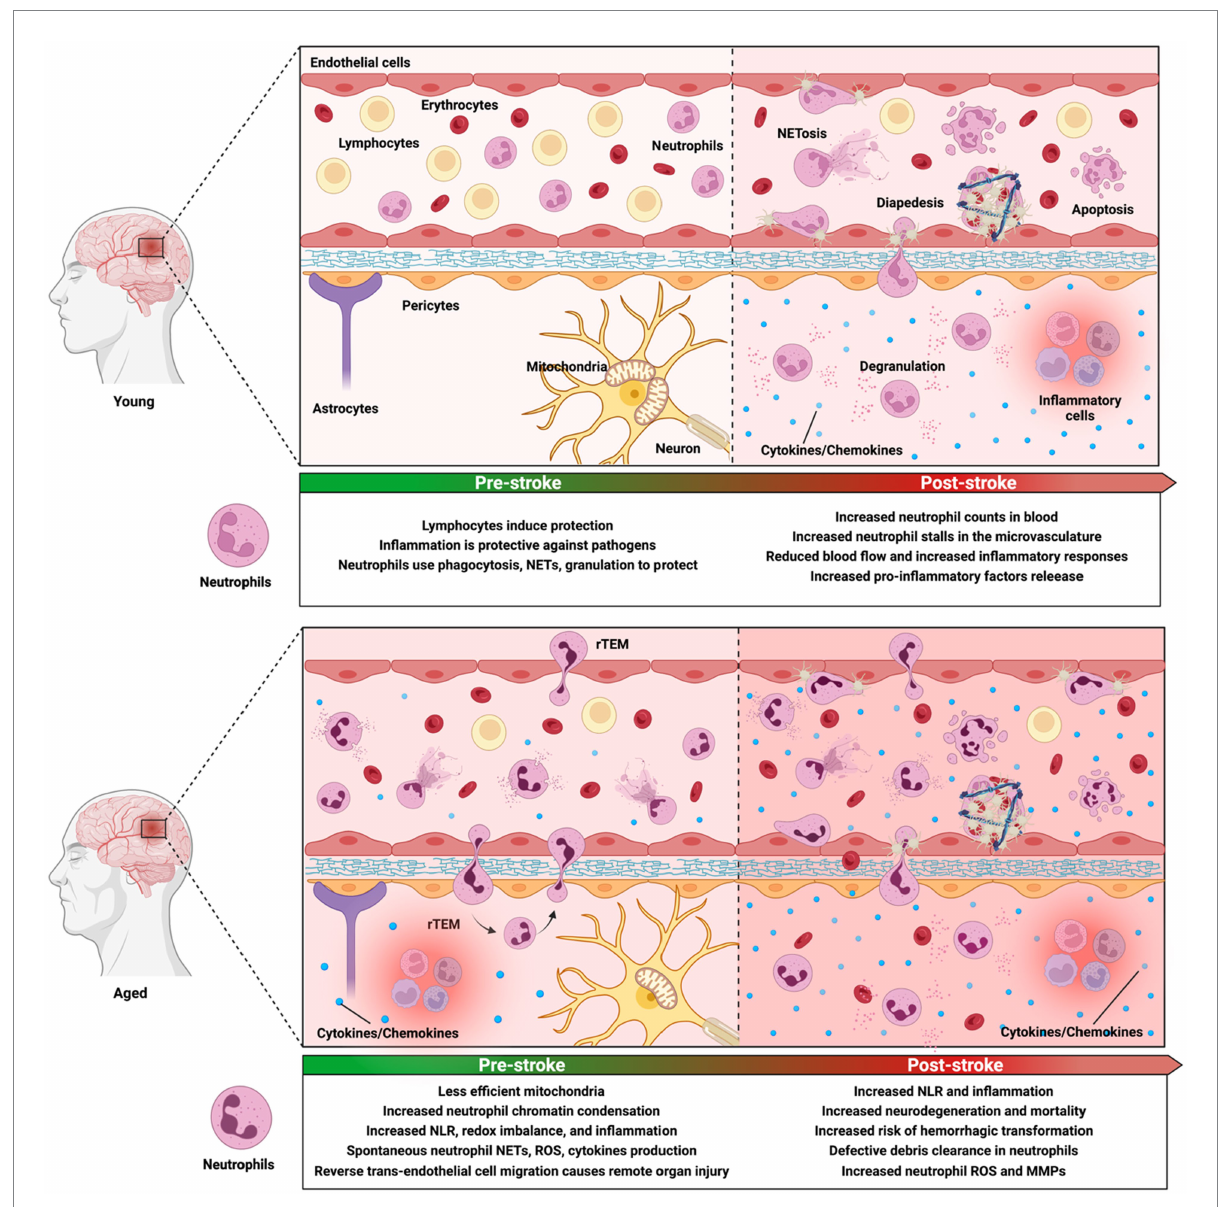
FIGURE 4 Aging alters the immune microenvironment as well as neutrophil phenotype and functions both before and after ischemic stroke. In normal condition, inflammation serves as a mechanism that protects the body against pathogens. Upon encountering pathogens, neutrophils undergo immune responses by producing granules, releasing neutrophil extracellular traps (NETs) and reactive species, and performing phagocytosis. Ischemic injury induces significant changes in the microvasculature, including increased neutrophil count, neutrophil stalls, and aberrant neutrophil activities that are correlated with neurological deficits and poor outcomes. During aging, the brain is primed with a basal elevated neuroinflammatory environment, which is evident in less efficient mitochondria, chemical gradient loss, and increased basal neutrophil counts and pro-inflammatory activities. With aging, due to increased levels of CXCL1 production, a higher level of neutrophil reverse transendothelial migration (rTEM) is seen. After neutrophils undergo diapesis, they can re-enter the vascular lumen and return to the circulation. They can stay in downstream organs, causing multiorgan failure. Aged individuals are significantly more susceptible to ischemic injuries than young individuals. They have increased risk of hemorrhagic transformation and worse neurological deficits. Their system has defective neutrophil clearance and heightened reactive species and MMP-9, causing sustained inflammatory responses. These further ischemic injuries and cause significantly more irreversible damage in aged